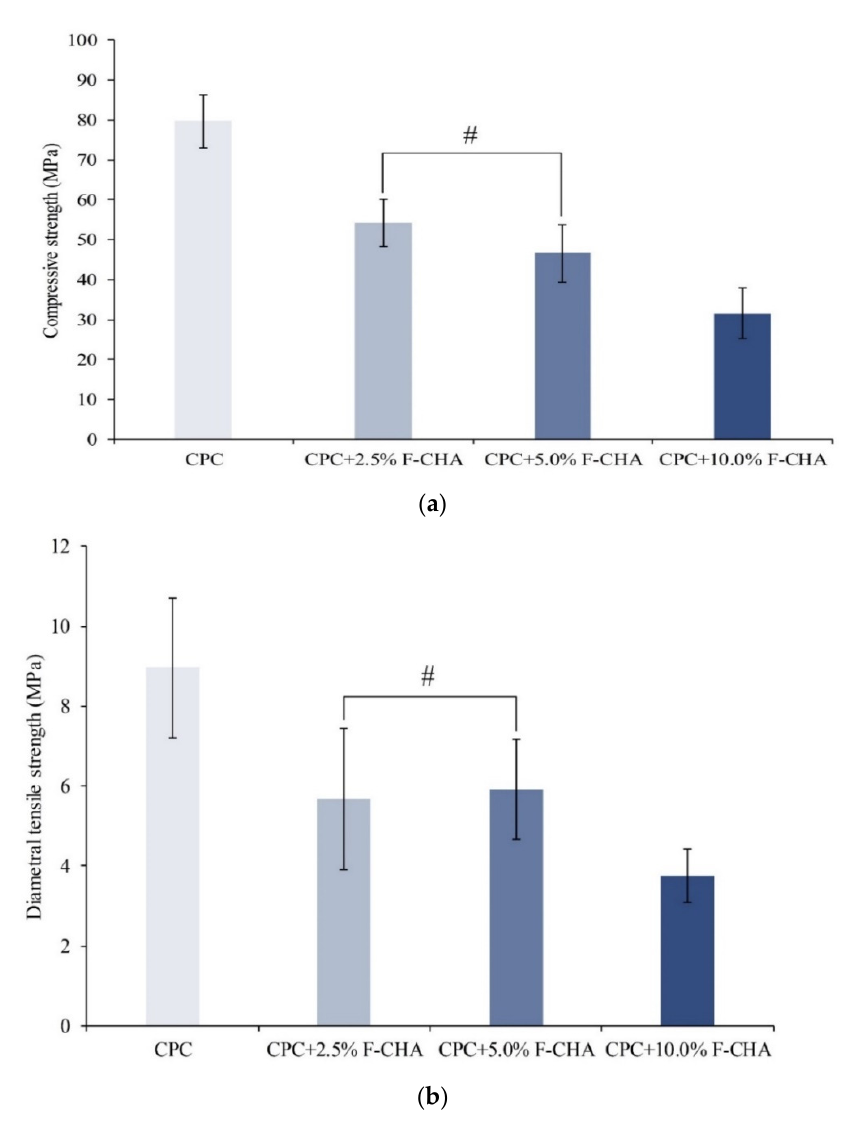
Figure 6. Compressive strength ( a ) and diametral tensile strength ( b ) of CPC composites with different ratios of ferulic acid-carbonated apatite nanorods after immersion in TBS for 1 day. Groups marked # indicate non-significant differences ( n = 6; p > 0.05).